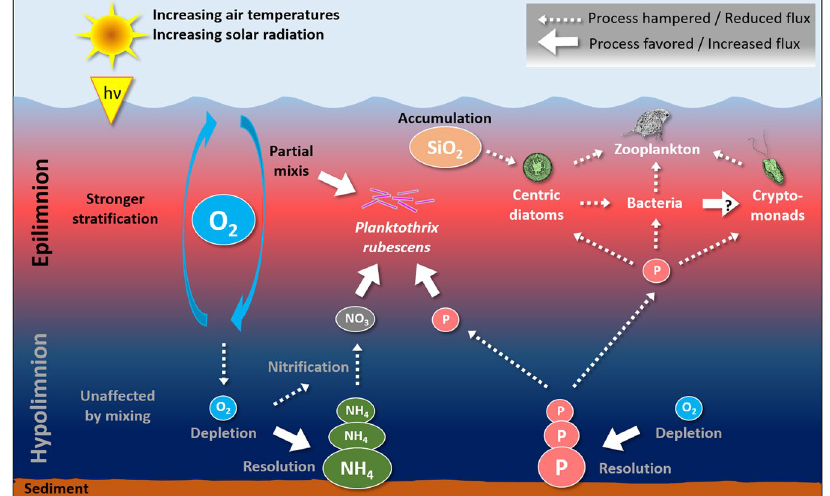
Figure 4. A conceptual view of the major effects of climate warming on water turnover dynamics, primary producers and limiting nutrients in Lake Zurich. Rises in air temperatures cause stronger water column stratifications which impede complete water turnovers (holomixis) during spring. Incomplete mixis favors survival of the cyanobacterium Planktothrix rubescens , but reduces the import of limiting nutrients from the hypo- to the epilimnion. The quantitative most important vernal primary producers (centric diatoms and cryptophytes) are negatively affected due to phosphorus limitation. In addition, reduced mixis impedes down- welling of oxygen-rich epilimnetic water, leading to hypolimnetic anoxia and resolution of nutrients from sediments. At present nutrients accumulate in deep water layers owing to insufficient vernal